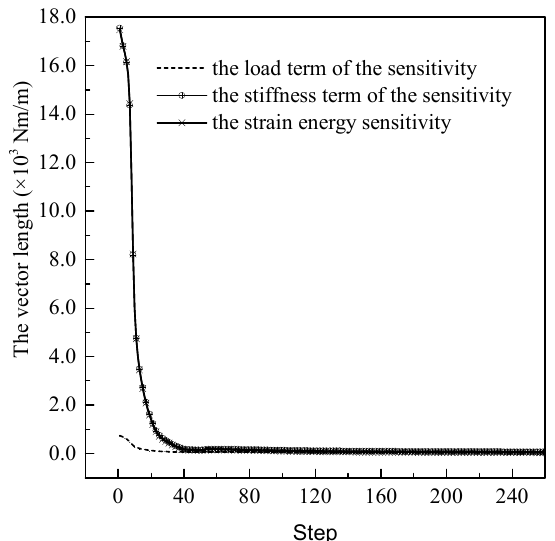
Figure 9. The vector length of the load term, the stiffness term, and the whole value of the structural strain energy sensitivity in Scheme A.